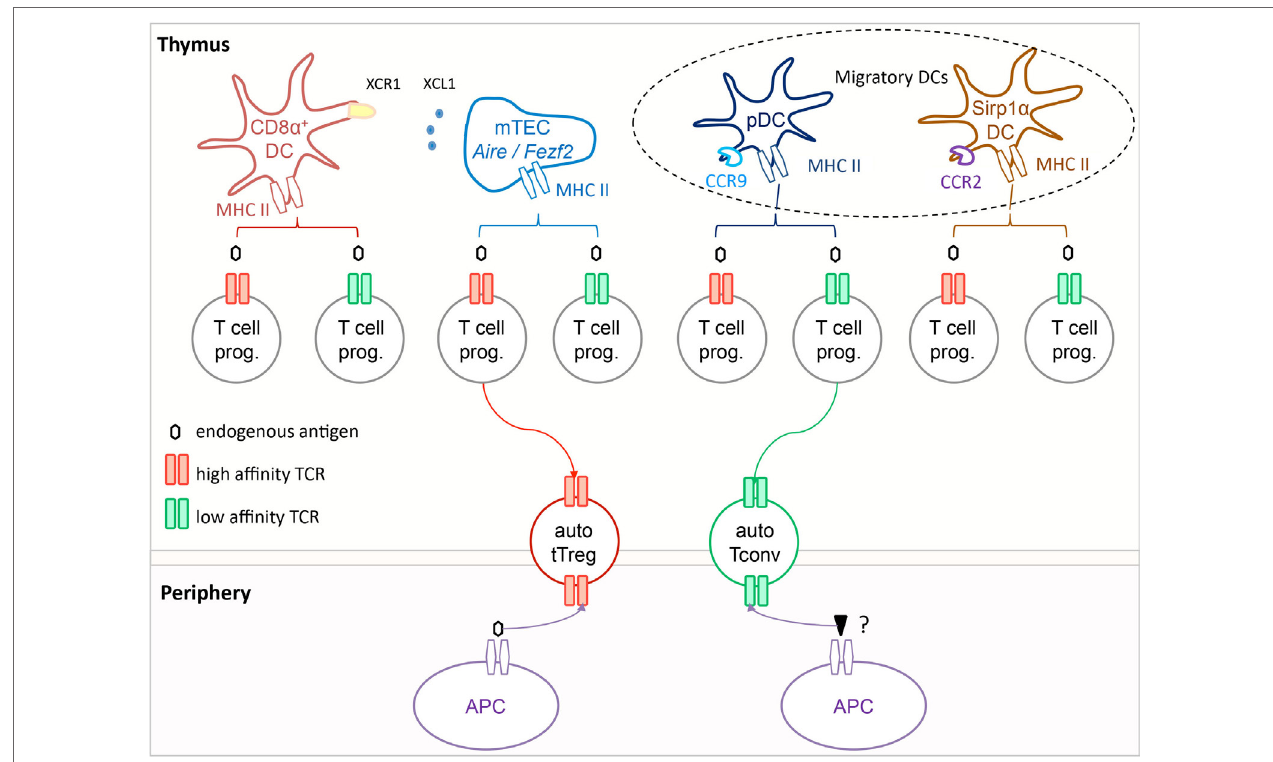
FiGURe 1 | Autoreactive tTreg are selected in the thymus on self-antigens via T cell receptor (TCR) interactions of high functional affinity. In the thymus, T cell progenitors expressing TCR of high functional affinity (red) for self-antigens are selected into the tTreg compartment, while those expressing TCR of low functional affinity (green) are selected to become Tconv. The antigen-presenting cell can be a medullary thymic epithelial cells (mTEC), a resident CD8 α + dendritic cells (DC), or a migratory pDC or SIRP1 α + DC, or possibly a combination of these if the selection process involves multiple T cell–APC contacts. In the periphery, tTreg appear to react primarily toward the self-antigen that mediated their development, while Tconv respond most efficiently toward distinct non-self-antigens. It is noteworthy that all Tconv are positively selected, and hence have a certain degree of